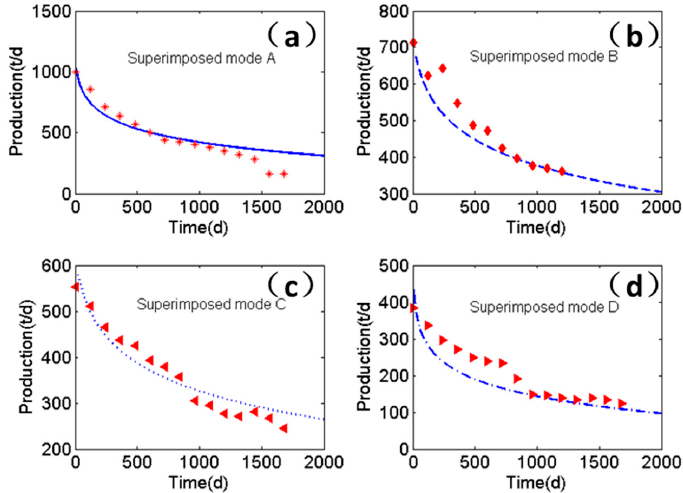
Figure 4. Comparison of actual production data and the present model with different superimposed modes: ( a ) superimposed mode A; ( b ) superimposed mode B; ( c ) superimposed mode C; ( d ) superimposed mode D.